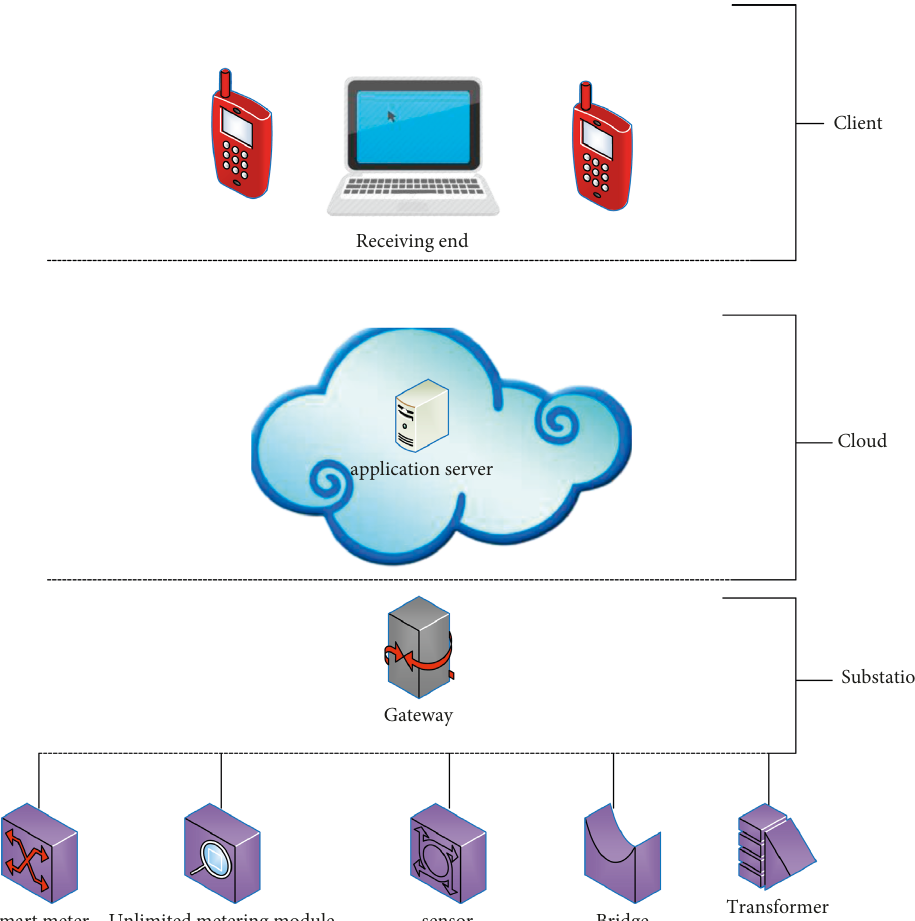
Figure 4: The structure of the Internet of